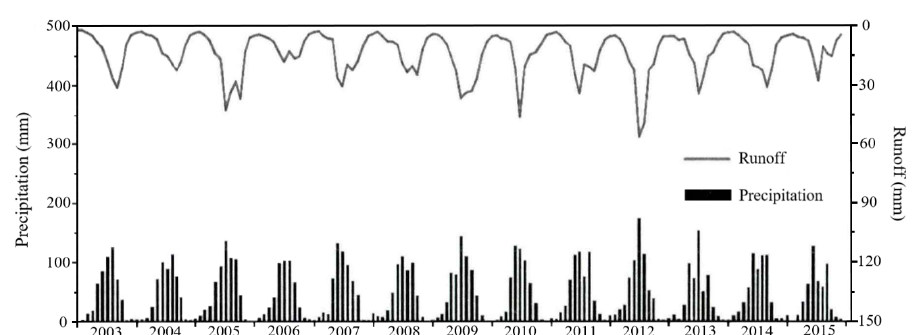
Figure 13. Monthly time series of precipitation and runoff across the Source Region of the Yellow River during the period 2003–2015 [47].